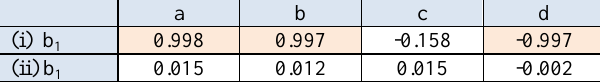
Table 2: Correlation between full collimation axis error model and (i) vertical plane (ii) horizontal plane